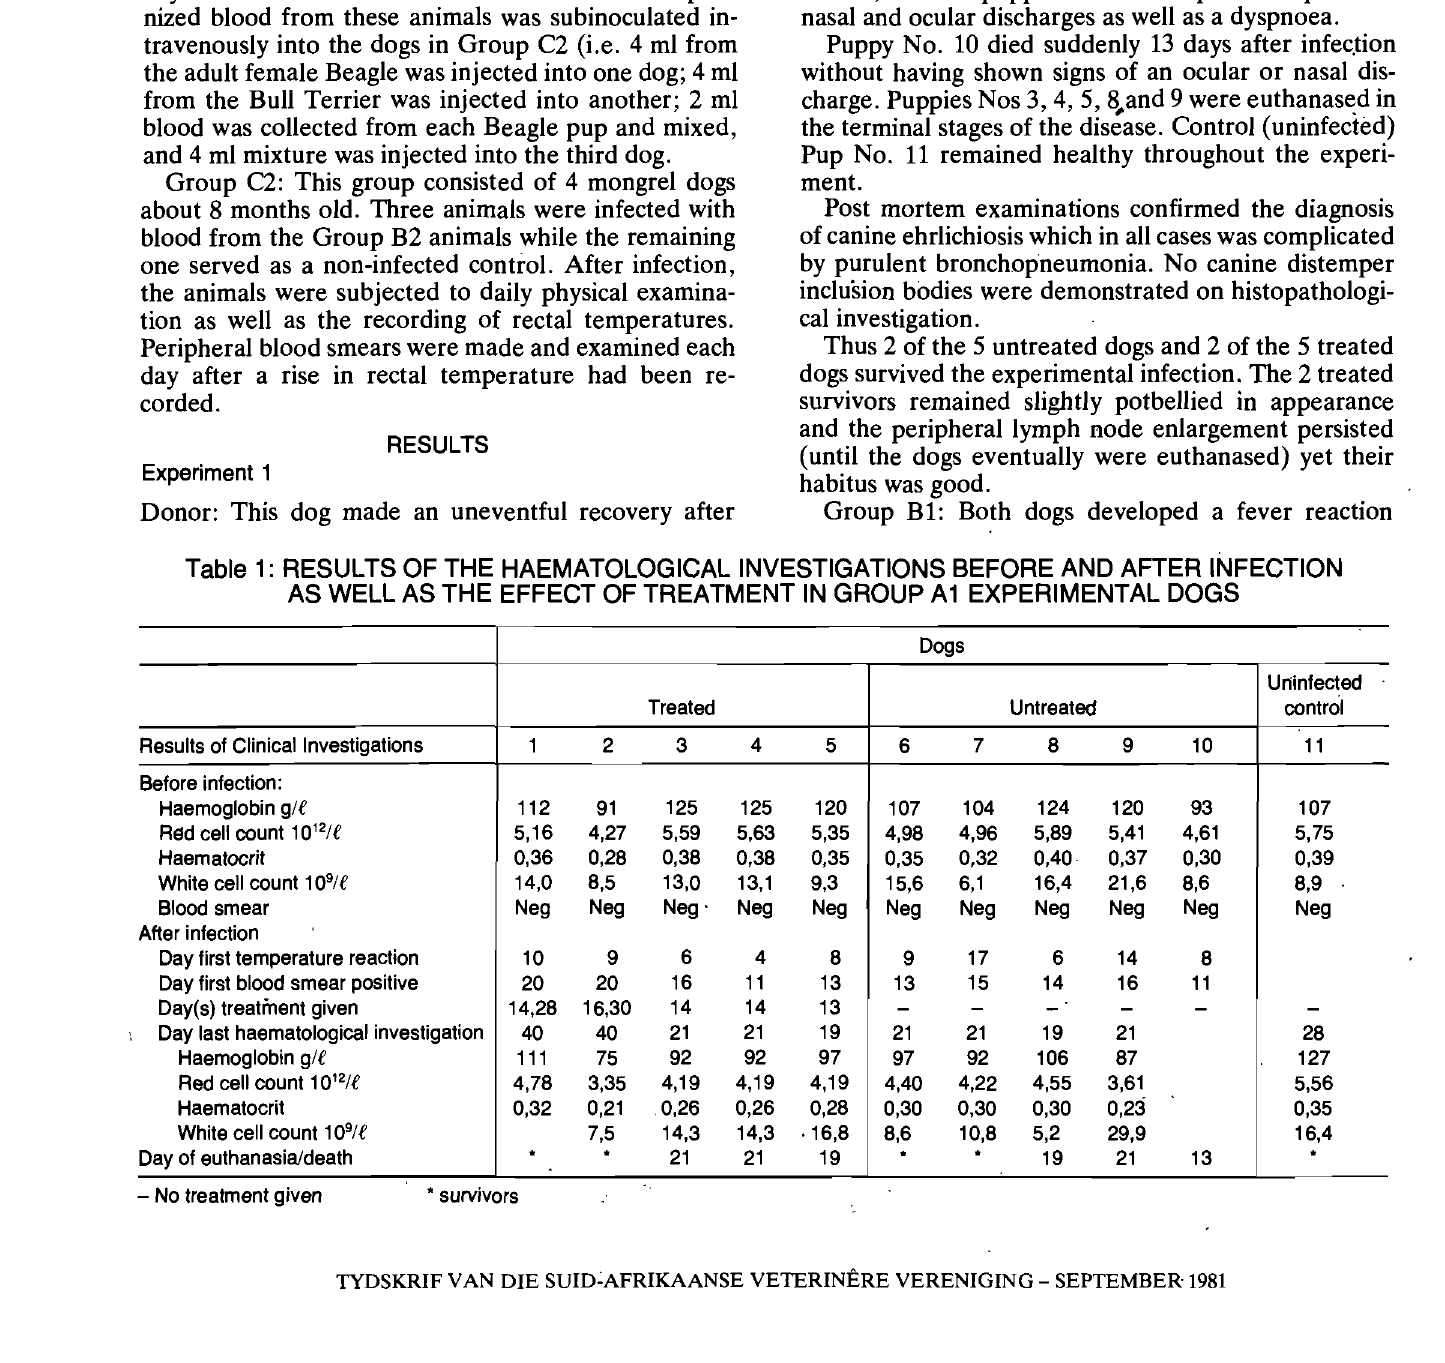
RSd cell count 10 12